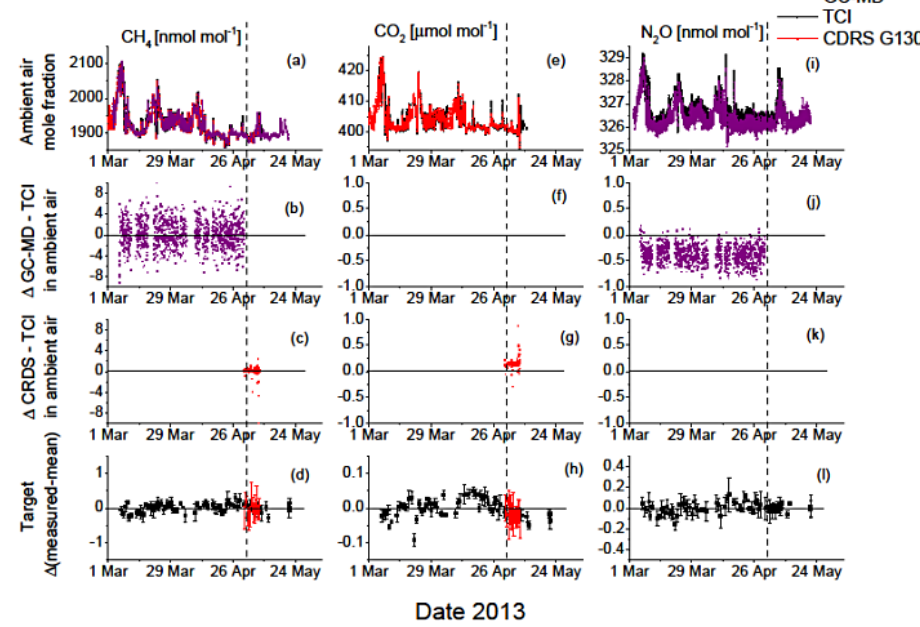
Figure 6. Upper panels: mole fraction of (a) CH 4 , (e) CO 2 and (i) N 2 O during the measurement campaign at Mace Head. All instruments were running in parallel with the TCI with independent intake lines to the same height. The GC-MD measured at a height of 10m and the CRDS at a height of 25m. On 1 May 2013, the TCI intake was switched on for 10 to 25m (dashed vertical line). Here only comparisons of measurements made at the same height are shown and will be evaluated. Second row panels: difference between the GC-MD and the TCI for (b) CH 4 and (j) N 2 O from 6 March 2013 until 1 May 2013. Third row panels: difference between the CRDS G1301 and the TCI for (c) CH 4 and (g) CO 2 from 1 May 2013 until 7 May 2013. Lowest panels: TCI and CRDS daily target measurement deviation from mean for (d) CH 4 , (h) CO 2 and (i) N 2 O. No GC-MD target measurements are